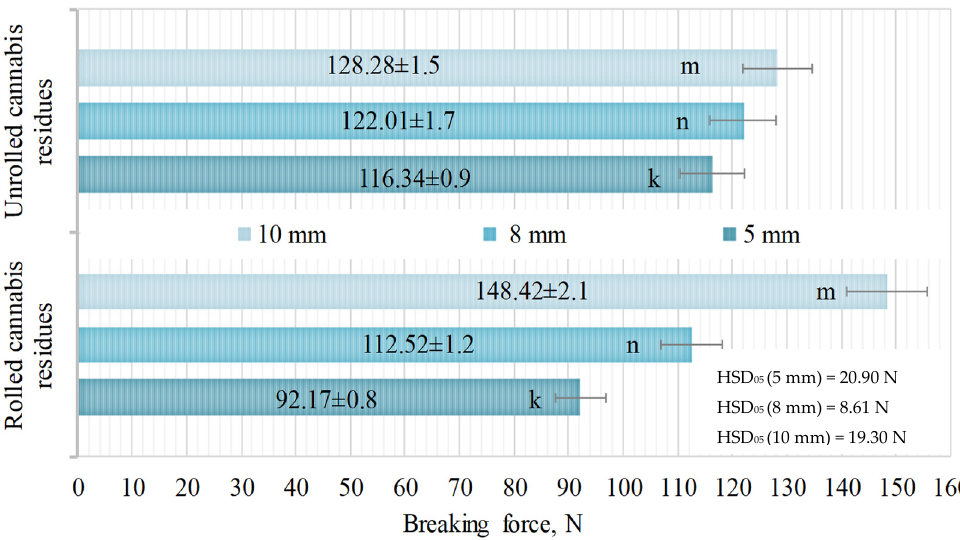
Figure 5. Breaking force demand for rolled and unrolled cannabis residues of different diameters. Columns marked with the same letter mean the results have significant differences (probability level P<0.05).